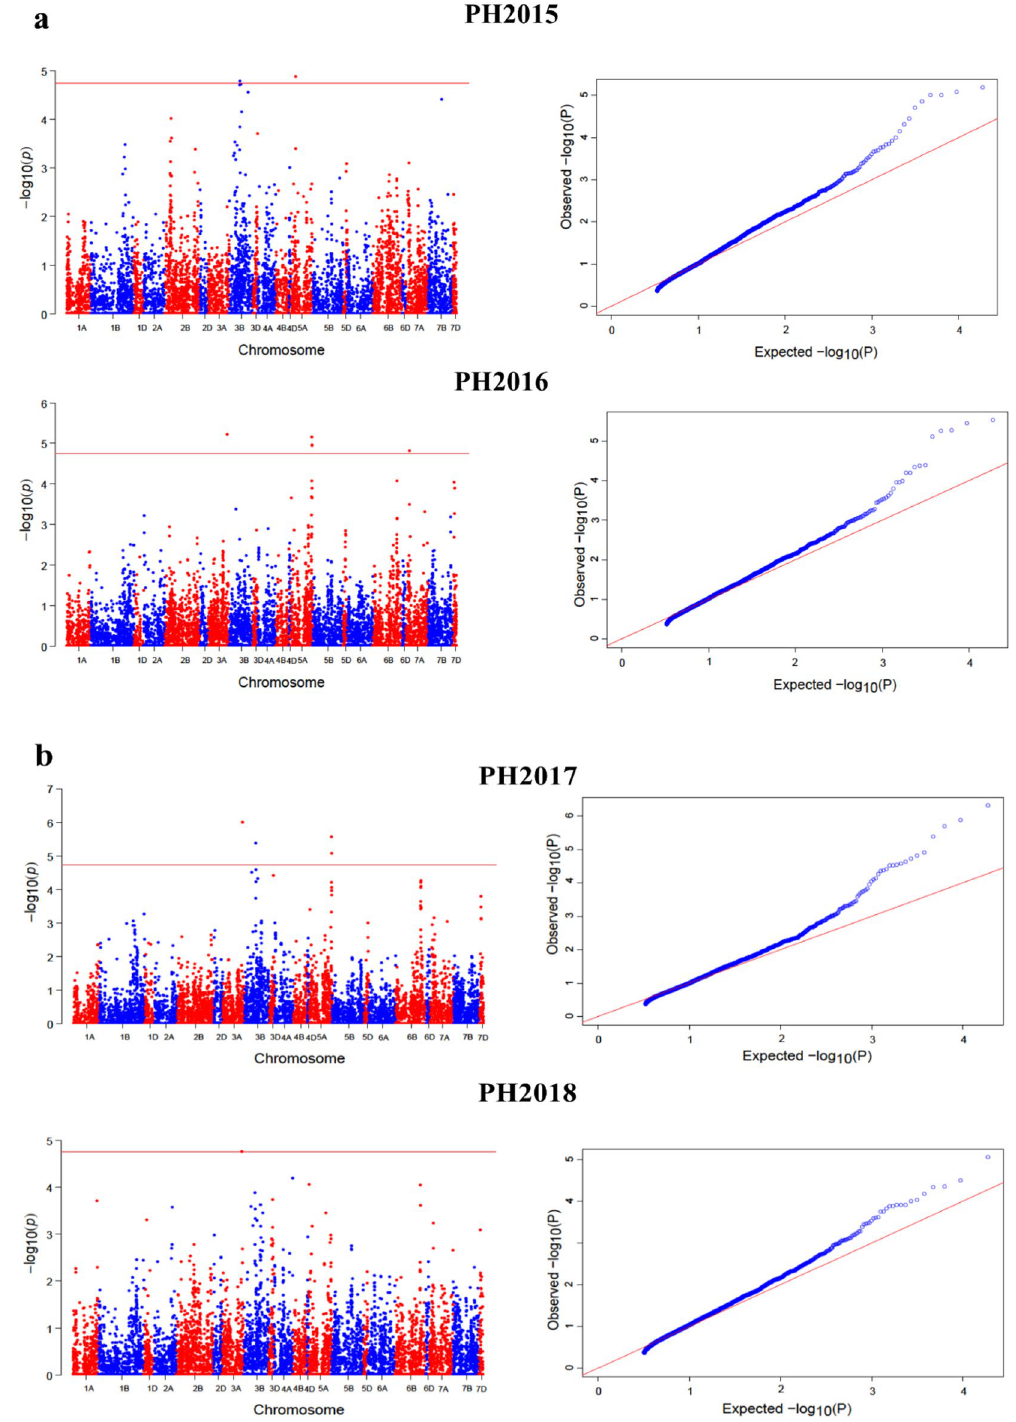
Figure 4. Manhattan and quantile–quantile (Q-Q) plots for plant architectural traits across different environments; ( a , b ) Manhattan and Q-Q plots for Plant height (2015–2018); ( c ) Manhattan and Q-Q plots for flag leaf length (2017–2018); ( d ) Manhattan and Q-Q plots for flag leaf width (2017–2018); ( e ) Manhattan and Q-Q plots for number of tillers (2017–2018). Note: Number of detected SNPs by four multi-locus GWAS methods. For brevity, we presented here the Manhattan and Q–Q plots of mrMLM model. The rest of the Manhattan and Q–Q plots are given in Supplementary Fig.